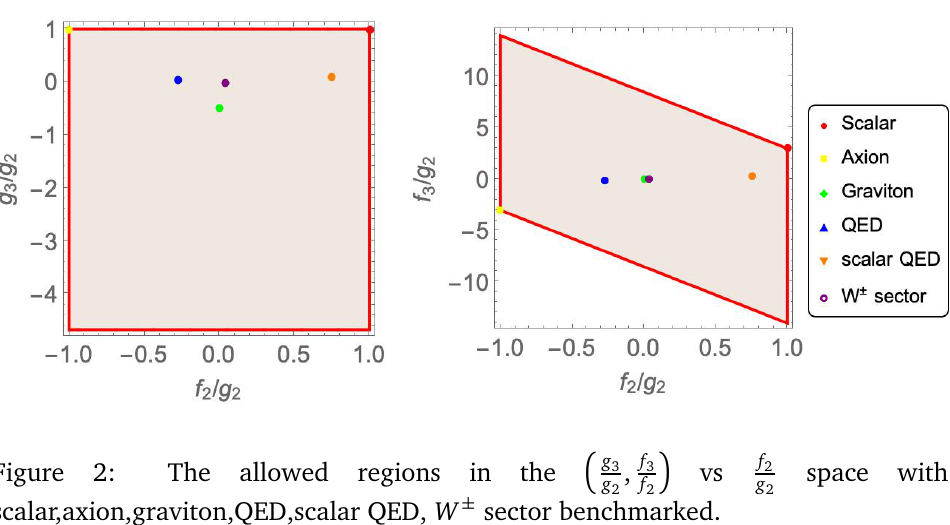
Figure 2: The allowed regions in the scalar,axion,graviton,QED,scalar QED, W ± sector